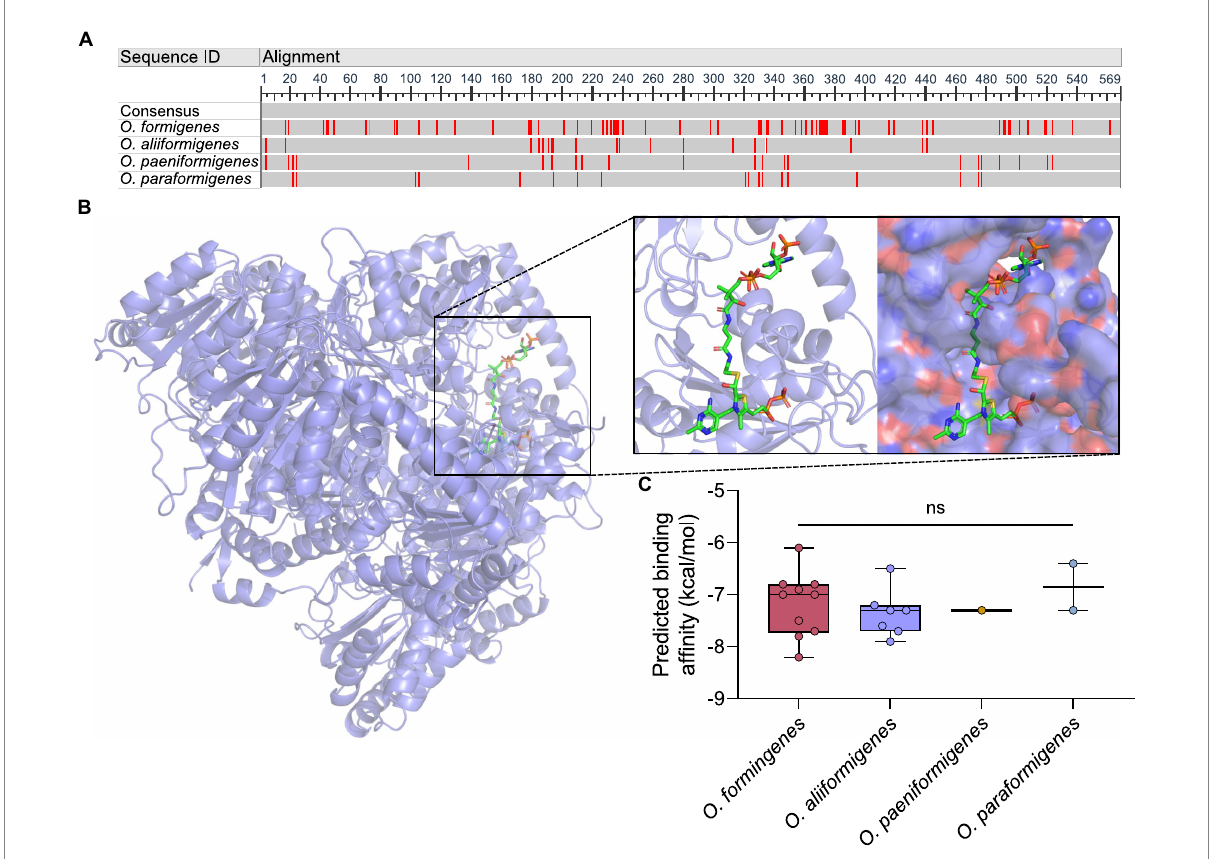
FIGURE 4 In silico analysis of oxalyl-CoA decarboxylase. (A) Consensus alignment of the oxalyl-CoA decarboxylase amino acid sequence for each Oxalobacter species. Red regions indicate nucleotides different than the consensus sequence. Dark gray regions show gaps in the gene. Light gray regions show similarity. (B) Three dimensional in silico ribbon model reconstruction of the oxalyl-CoA decarboxylase. Also shown is the binding of the natural ligand, oxalyl-CoA, in a ribbon and space filling structure. (C) Predicted binding affinity of each model protein with the natural ligand. Data are displayed as median predicted binding affinity (kcal/mol) and analyzed by one-way ANOVA. In box plot diagrams, circles represent data point, boxes represent first and third quartile values while black lines denote medians, and whiskers encompass maximum and minimum values. ns, not